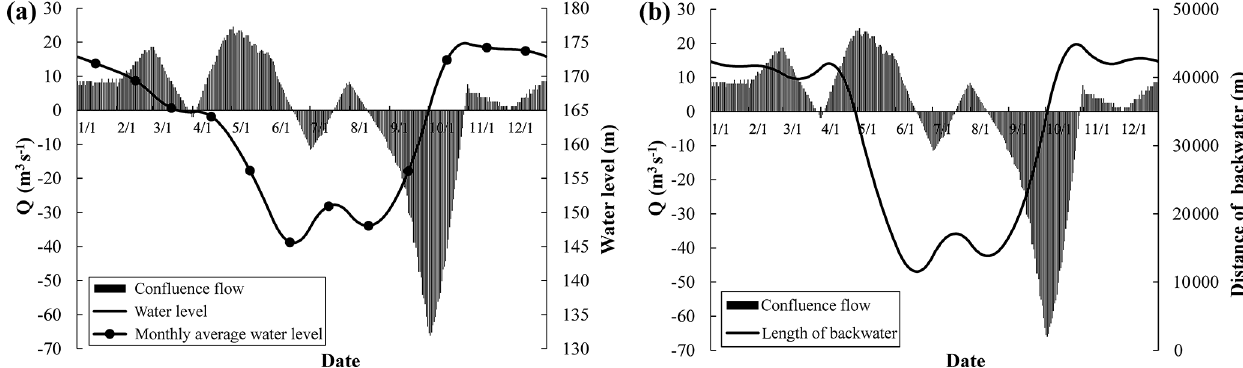
Figure 6. Relationships among water level, length of backwater, and confluence flow. (a) Daily variations in confluence flow and water level and (b) daily variations in confluence flow and length of backwater.